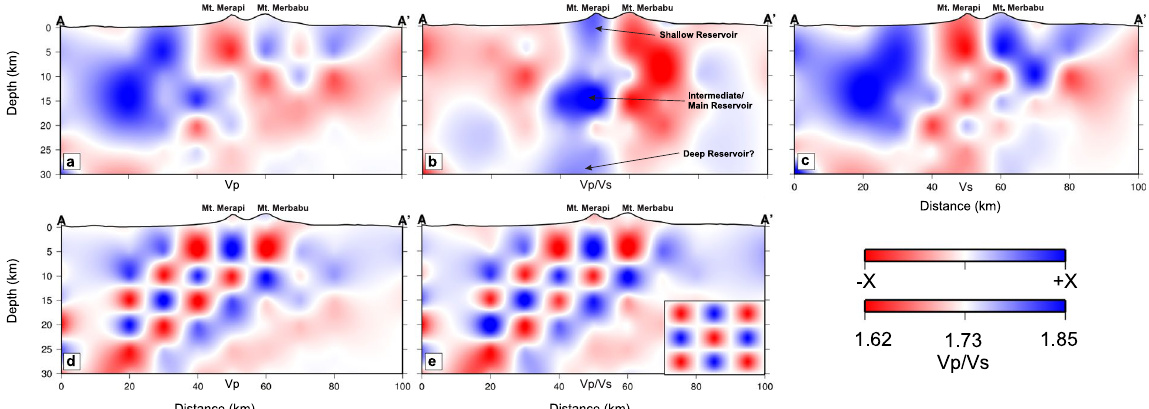
Figure 3. South-North vertical sections across Merapi and Merbabu. ( a ) Vp, ( b ) Vp/Vs, ( c ) Vs, ( d ) checkerboard recovery for Vp, and ( e ) same as ( d ) but for Vp/Vs. The input pattern of the checkerboard test is shown in the inset in ( e ) with input perturbations of X = 10% for both Vp and Vp/Vs as in Fig. 2. Vp and Vs are plotted as perturbations with X = 12% relative to the 1D model based on Koulakov et al . 18 and X = 5% for the checkerboard recovery for Vp and Vp/Vs; while Vp/Vs is plotted as absolute values.